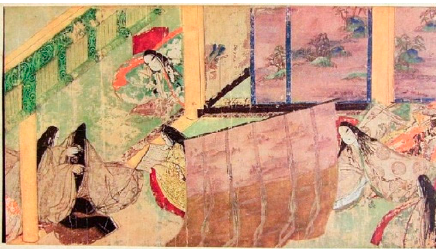
Figure 2. Azumaya , “The Eastern House”, image from the Genji monogatari emaki ( https://commons.wikimedia.org/wiki/File:Genji_emaki_azumaya.jpg, public